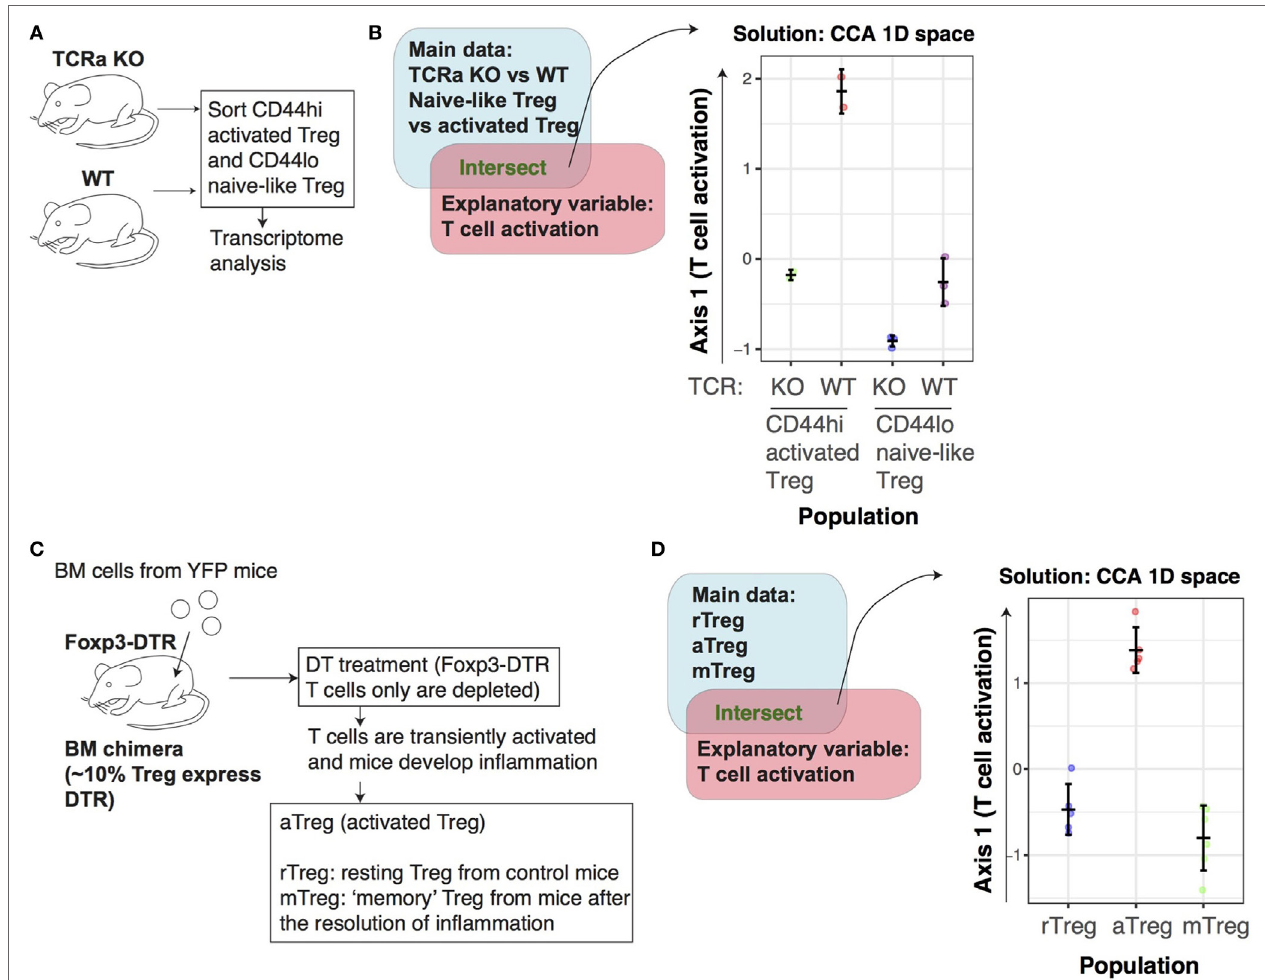
FigUre 6 | The activation signature of Treg is dependent on T cell receptor (TCR) signaling. (a) The experimental design for the TCR dataset. CD44 hi activated Treg (aTreg) and CD44 lo naïve Treg were obtained from Tcra KO or WT mice and analyzed by transcriptome analysis. (B) Canonical correspondence analysis (CCA) was applied to the transcriptome data of CD44 lo CD62 hi naïve and CD44 hi CD62 lo aTreg cell populations from inducible Tcra KO or WT (from the TCR KO data, GSE61077), using the T cell activation variable as the explanatory variable. This produces a 1D CCA solution, and the sample score was plotted (representing “T cell activation score”). (c) The experimental design for the aTreg dataset. Bone marrow (BM) cells were obtained from Foxp3 GFPCreERT2 :Rosa26YFP mice (YFP mice), and transferred into Foxp3 GFP DTR mice (Foxp3-DTR mice), in order to make BM chimera, in which ~10% of Treg expressed DTR. Subsequently, diphtheria toxin was administered to these BM chimeras, which depleted Foxp3-DTR cells but not donor cells. This treatment induced a transient activation of T cells and inflammation in vivo . aTreg were obtained from these mice with inflammation, while resting Treg (rTreg) were from control mice, and memory Treg (mTreg) were from the mice after the resolution of inflammation. (D) 1D CCA sample score plot of transcriptomic data of rTreg, in vivo aTreg, and mTreg from the aTreg data (GSE83315), with T cell activation variable as explanatory